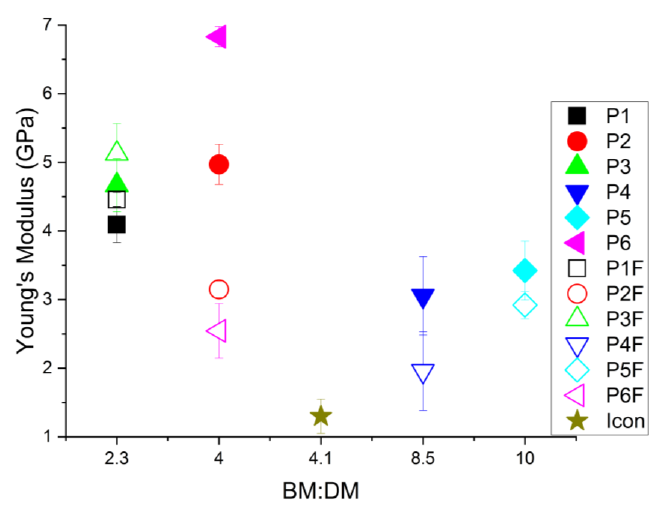
Figure 5. ( a ) Flexural strength of P1–P6 samples until fracture ( b ) Flexural strength of P1F–P6F samples until fracture.